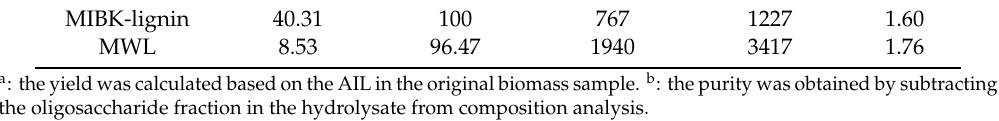
Table 1. The yields, purity, molecular weight, and polydispersity index (PDI) from MWL and MIBK-lignin. Component Yield a